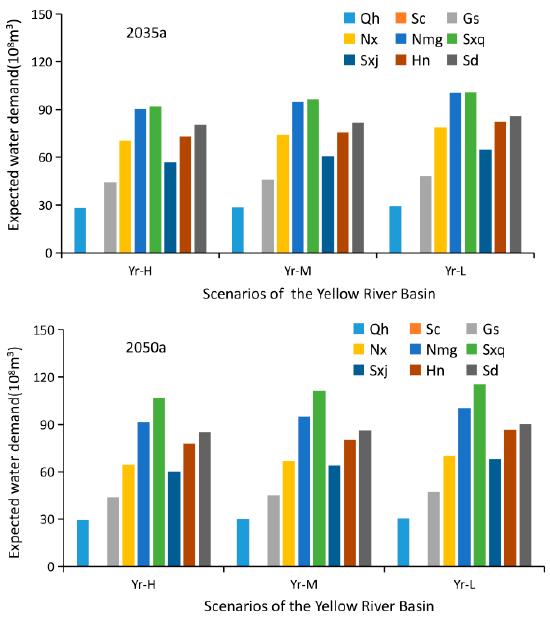
Figure 8. Expected water demand from each province in 2035a and 2050a. Table 3. Basic flow required for ecological purposes at the main control stations in the Yellow River Basin.